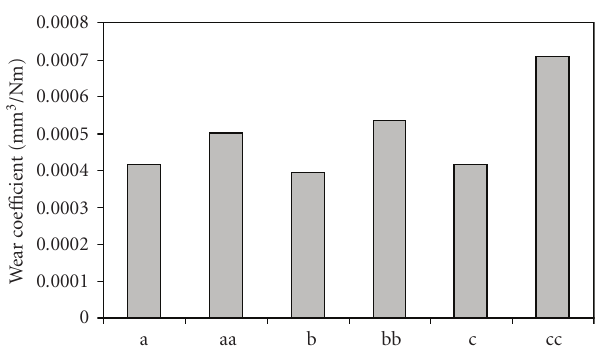
Figure 14: Results of the dry (DSRW) abrasion tests performed on (i) thick coatings on stainless steel substrates (single letter) and (ii) thin coatings on carbon steel substrates (double letter); SD 350 mm and various FD (see Table